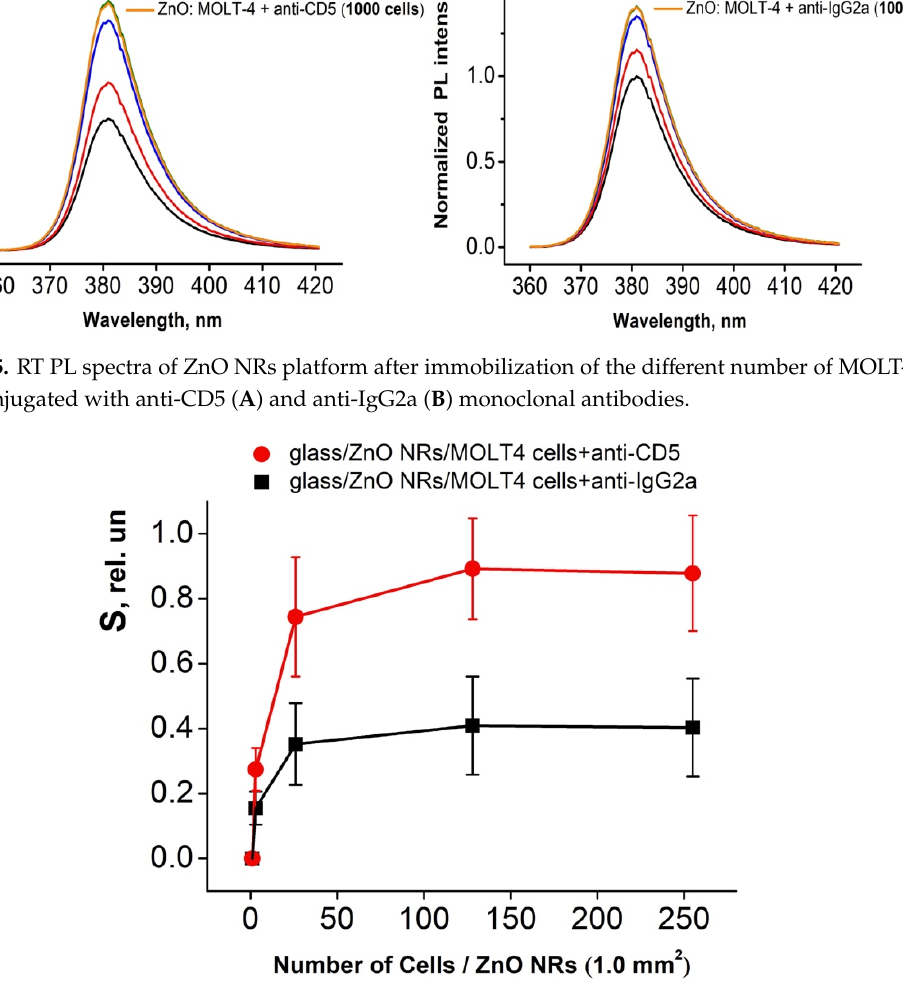
Figure 6. The dynamics of the relative RT PL intensity changes of the ZnO NRs platform after immobilization of the MOLT-4 cells conjugated with anti-CD5 and anti-IgG2a monoclonal